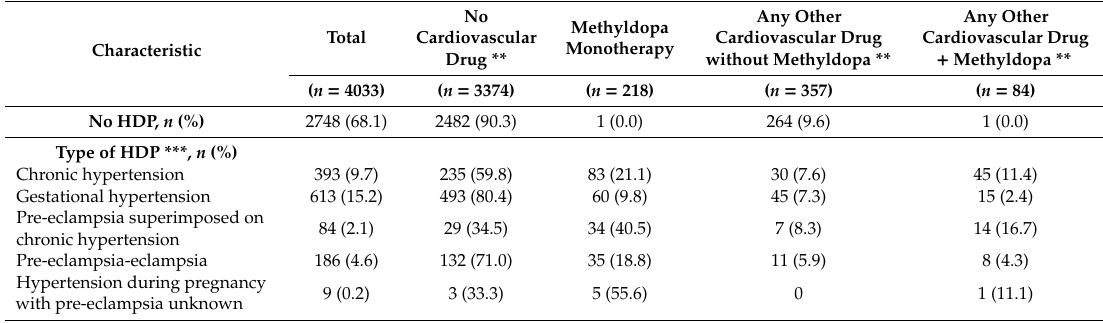
Table 2. Characteristics of cardiovascular therapy during pregnancy in women in the Pelotas cohort 2015, according to type of hypertensive disorder of pregnancy (HDP). ( n = 4033) *.